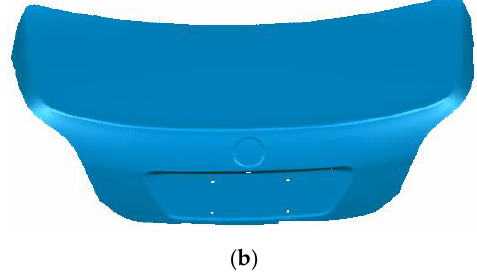
Figure 8. ( a ) Point cloud data fusion result; ( b ) triangular meshes representation.